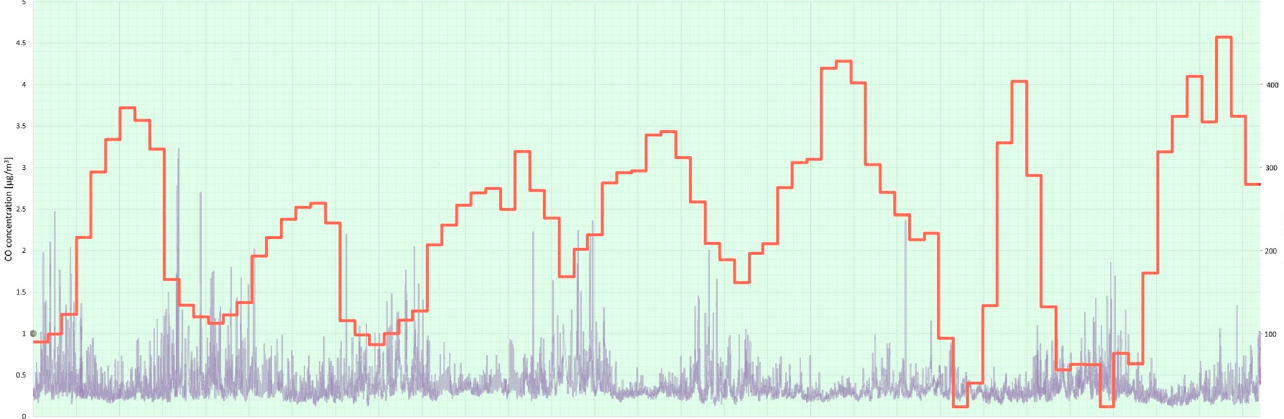
Figure 8. O 3 concentration in relation to tourist traffic (the Gda ń sk agglomeration, years 2015–2021). Source: own study.